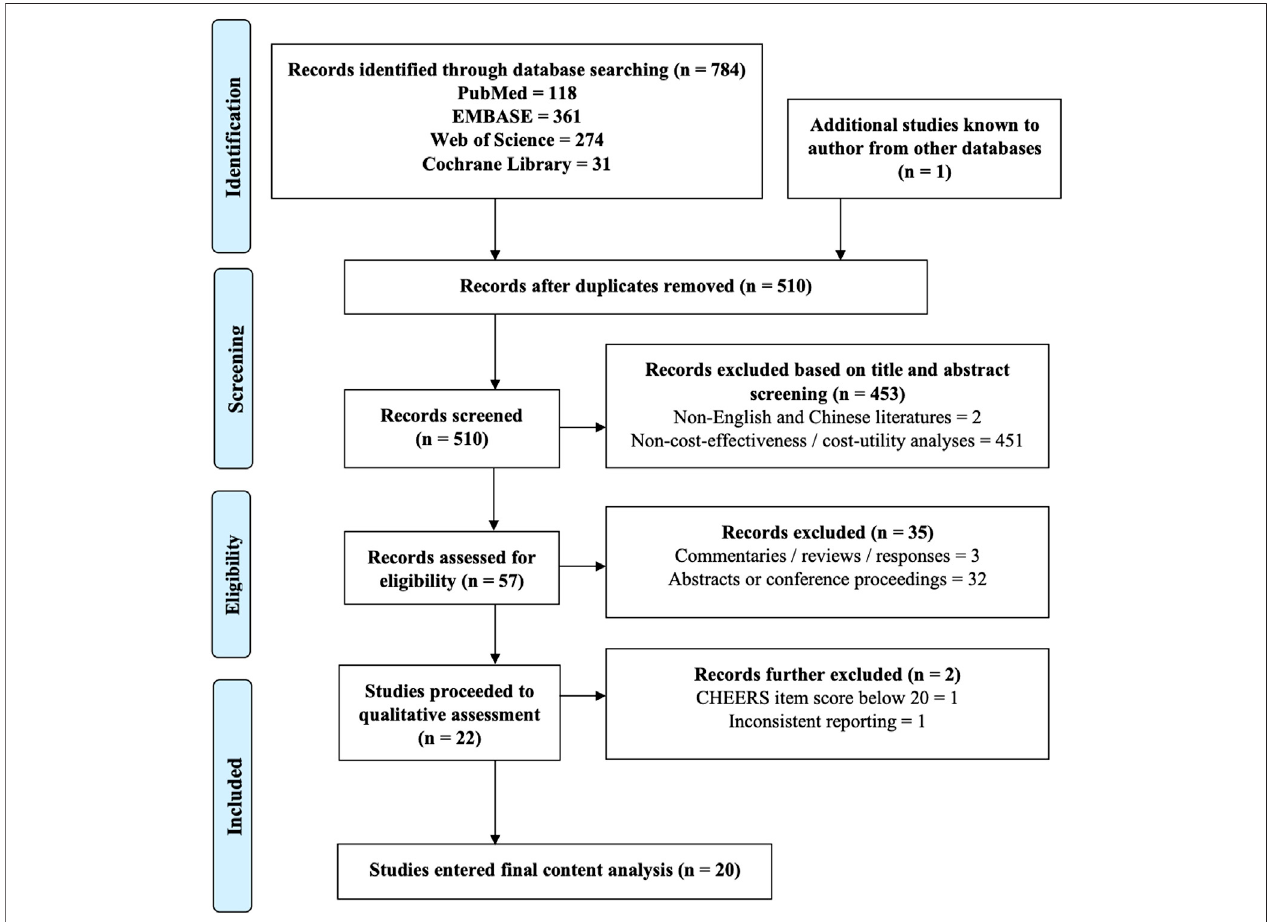
FIGURE 1 | Literature screening process based on 2018 PRISMA fl ow